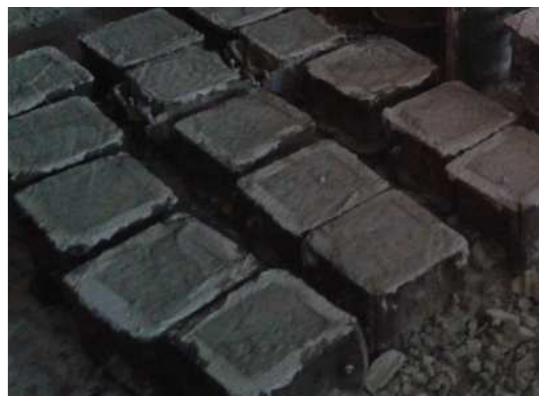
Figure 3. Cement–metakaolin concrete cubes.